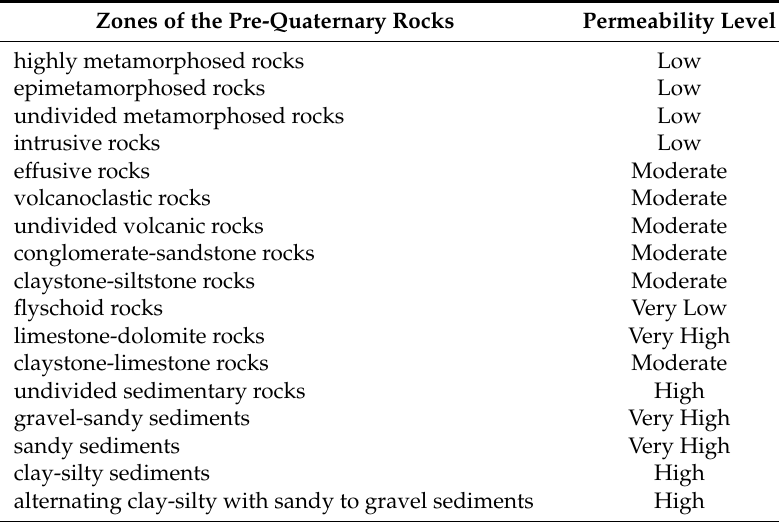
Table 3. Zones of rock types and their corresponding permeability